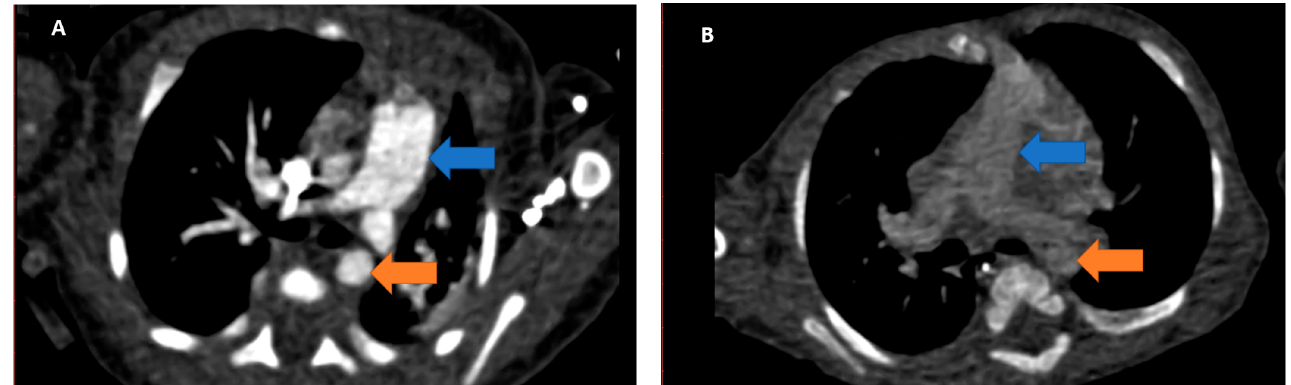
Figure 1. Axial CT angiography reconstruction. Blue arrow: main pulmonary artery. Orange arrow: descending aorta. ( A ) Excellent quality of image. The vascular structures are well-delineated due to good contrast opacification; ( B ) Suboptimal image quality. The vessels are difficult to delineate and reporting is